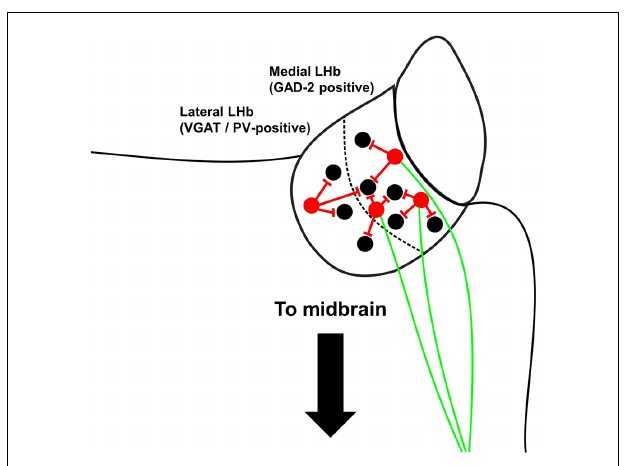
FIGURE 2 | Summary schematic of local inhibitory neurons within the mouse LHb. Locally-targeting inhibitory neurons (shown in red) in the medial LHb express glutamic acid decarboxylase 2 (GAD-2) but not vesicular GABA transporter (VGAT) and may also have excitatory projections to the tegmentum (shown in green), although note that Flanigan et al. (2020) found no evidence that inhibitory GAD-2-positive neurons project outside the LHb. Inhibitory neurons in the lateral LHb express VGAT and parvalbumin, but most do not express